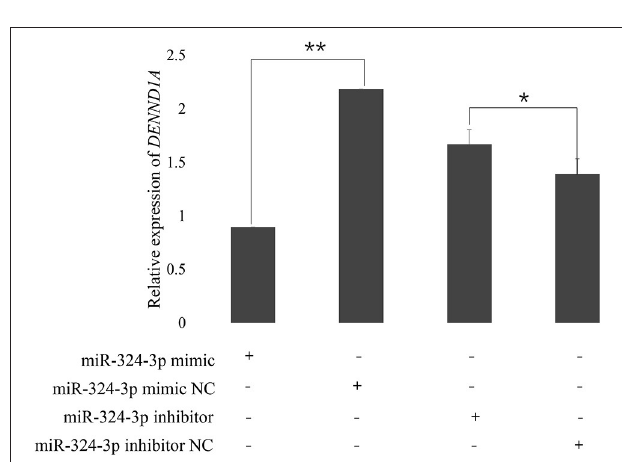
FIGURE 5 | Expression of DENND1A in goat GCs transfected with chi-miR-324-3p mimic or mimic NC, and inhibitor or inhibitor-NC at 48h. RPL19 was used as the reference gene. Results are representative of the mean ( ± standard deviation) of three independent analyses. * p < 0.05; ** p <